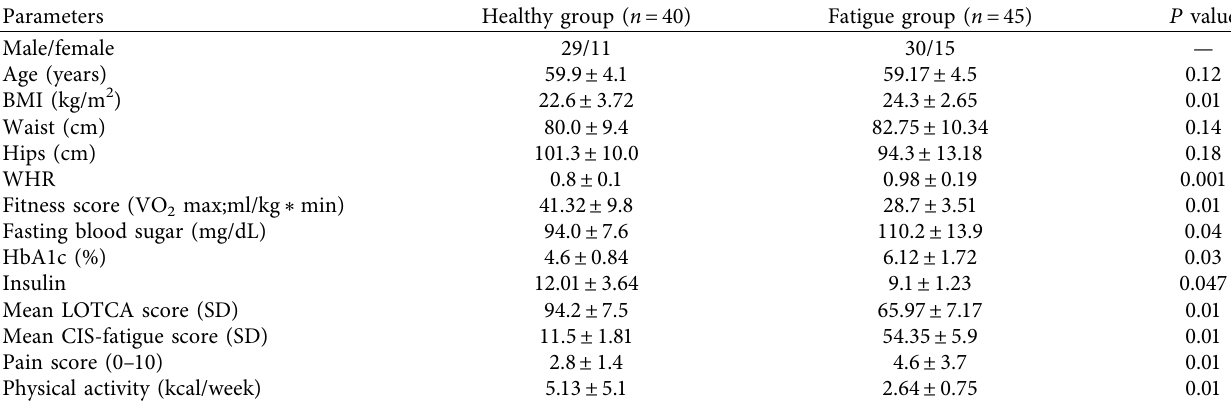
Table 1: General characteristics of